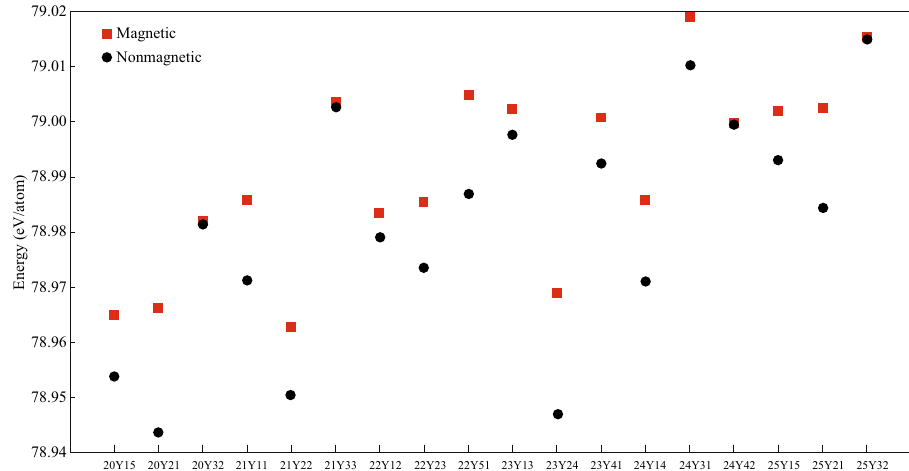
Fig. 7 Total energy per atom of 20YBNR is depicted in Fig. 8b in the ferromagnetic con- Fig. S4, which shows all the ribbons to be metals. figuration. The maximum of magnetic moment is equal to 0.58 l for 20Y15 , and to 0.7 l for 20Y21 . A spin ani- B B sotropy is found in 20Y21 with a magnetic moment of 0.7 l in the top edge and 0.68 l in the bottom edge. The B B anisotropy is directly dependent on the structural aniso- tropy and the inequality of bond length in two edges of the ribbon. The spin anisotropy is amplified in other widths of